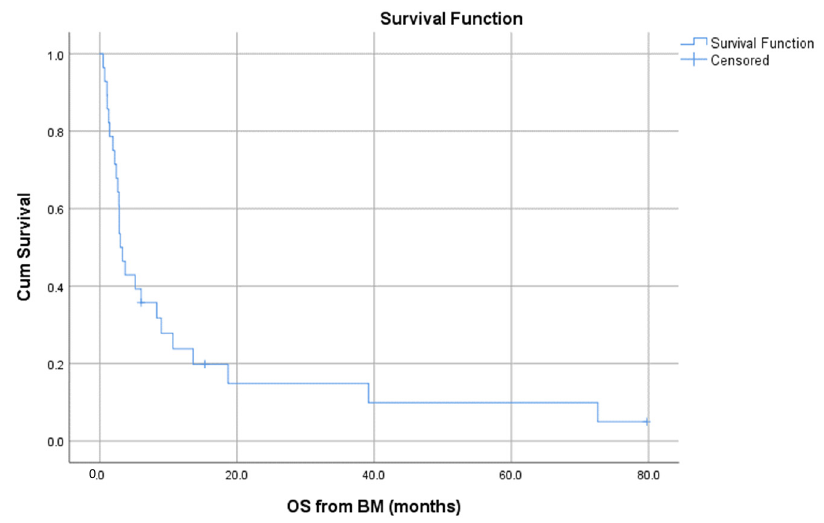
Figure 2. Overall survival from brain metastases diagnosis.